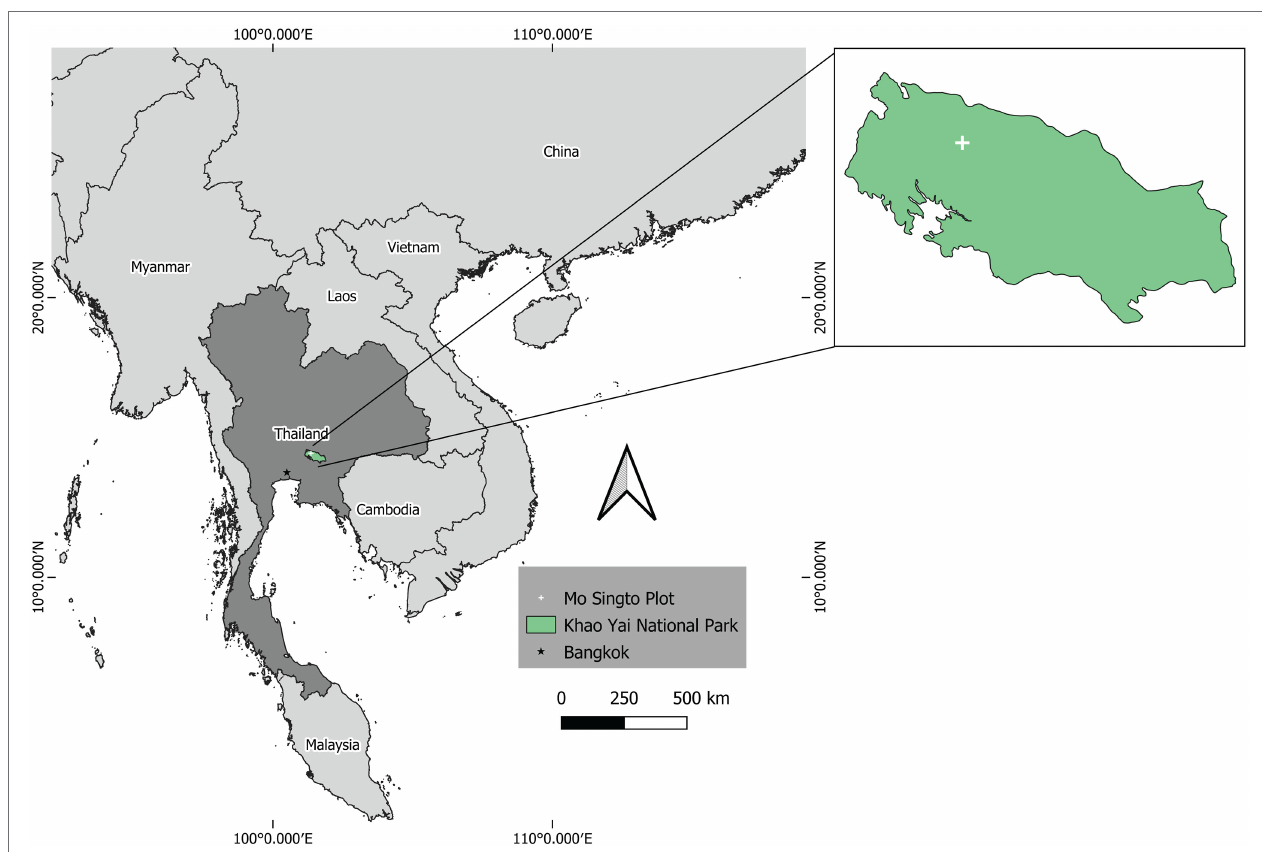
FIGURE 1 | Map of Khao Yai National Park and the Mo Singto